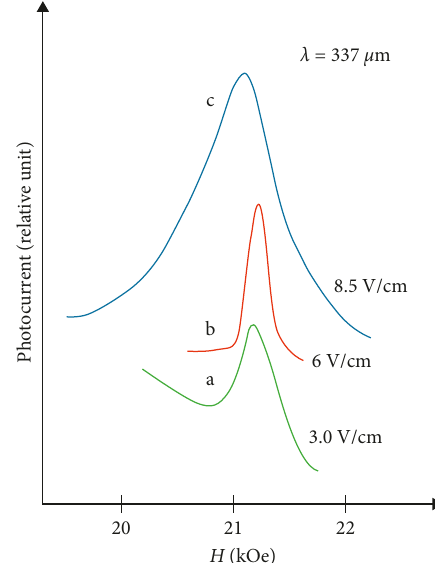
Figure 10: Shape of the CR line for the sample I at T � 4 . 2K with ≈ 5V · cm − 1 at different electric fields: (a) λ ≈ 337 μ m and ε BD ε < ε , (b) ε ≈ ε , and (c) ε > ε . As it is seen, the plasma shift is BD BD BD essential for the electric field higher than the breakdown value (the case (c)), where the line shifts to the left side.